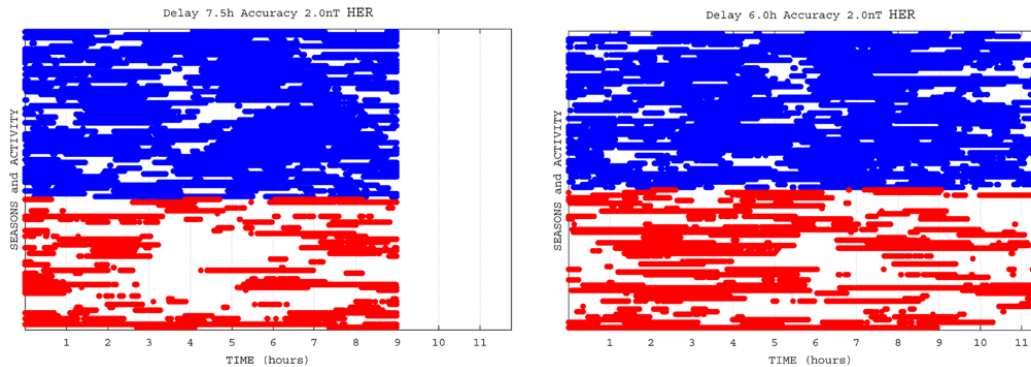
Fig. 10. Time table for HER data. Same legend as for Fig. 7.